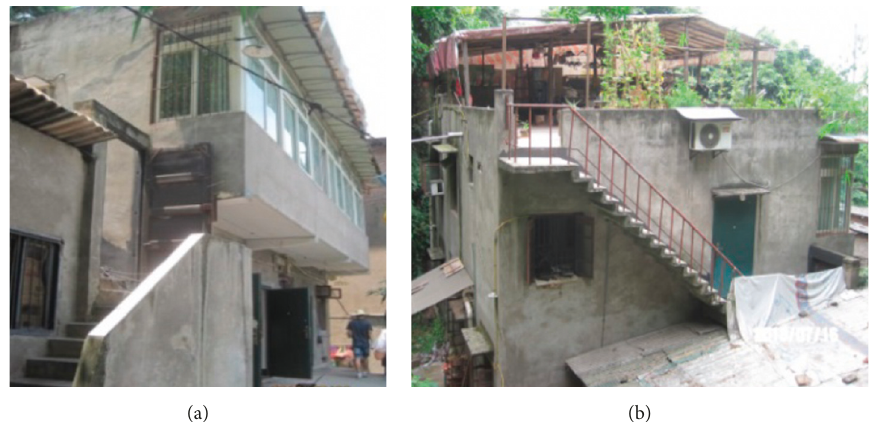
Figure 8: Photographs showing the two-storey masonry